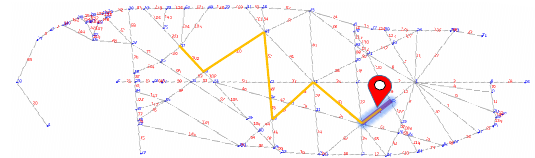
Figure 8. Localization example. The highlighted edge is the estimated position with the highest probability.